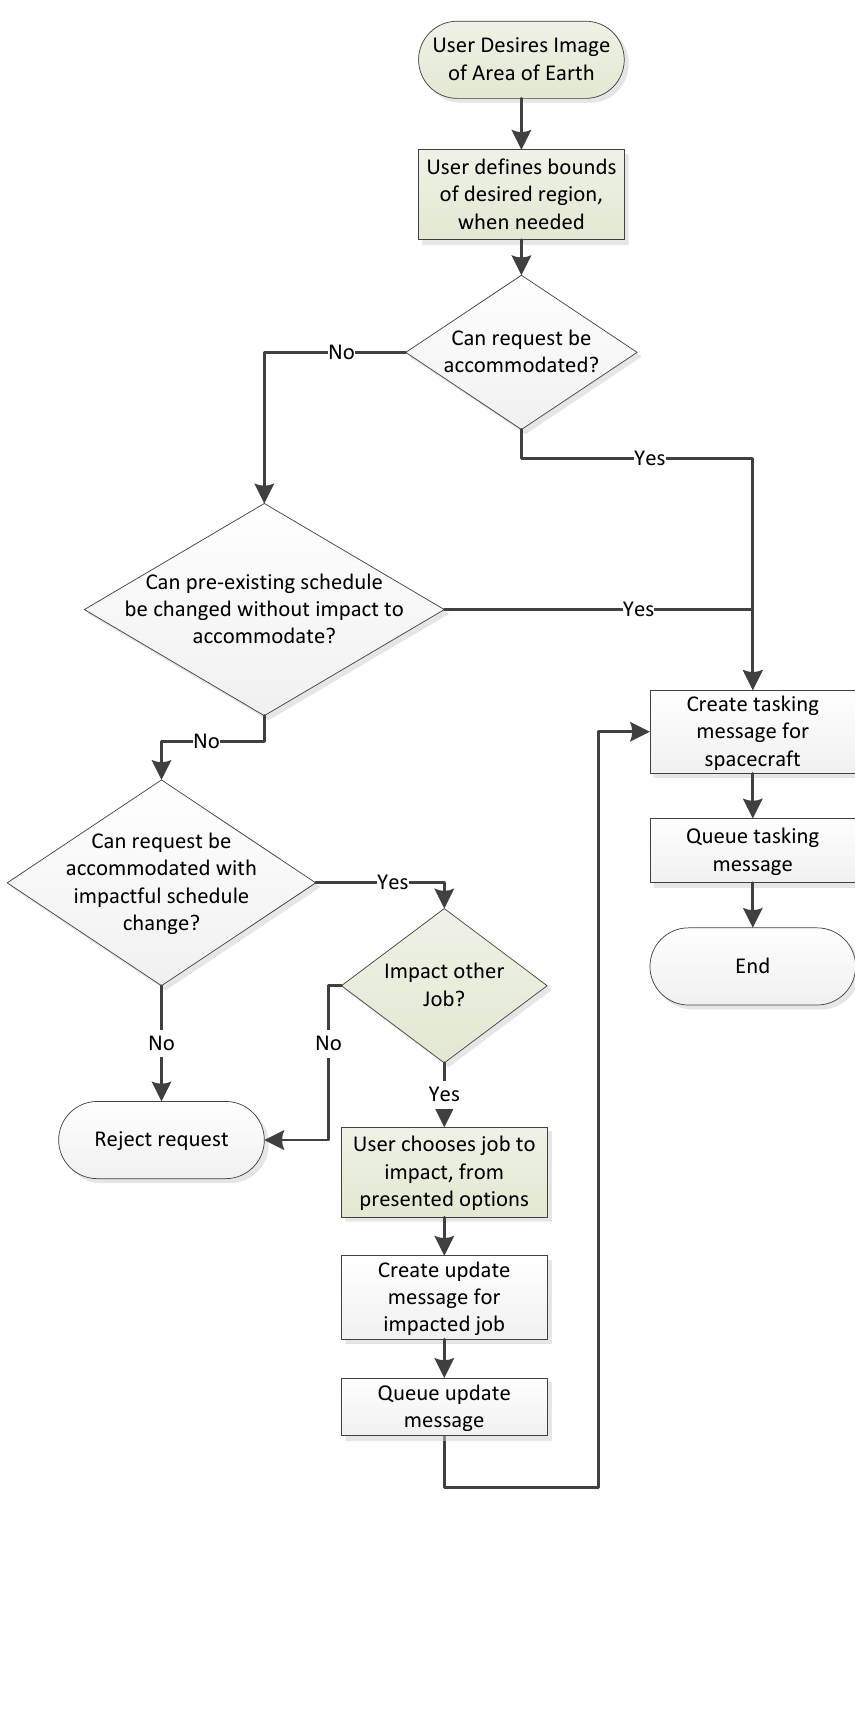
Figure 5. Ground Station Tasking Flow